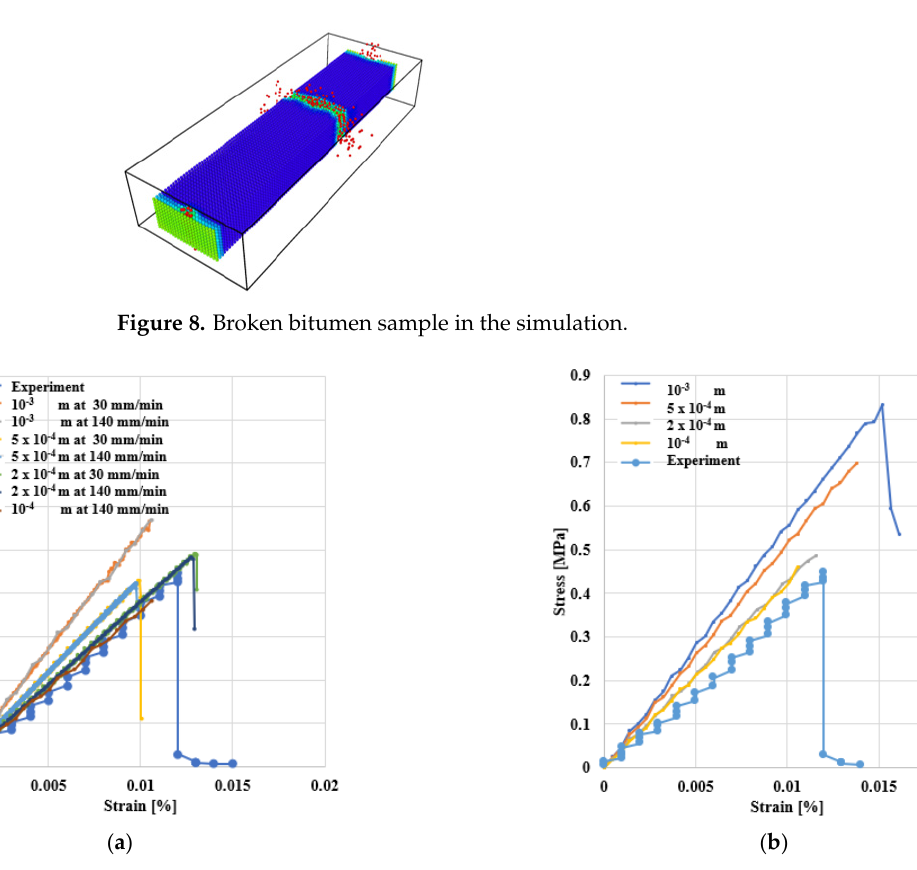
Figure 9. Stress/strain of bitumen beams at different resolutions and loading rate and comparison with other experiments [45]. ( a ) In 3D and ( b ) as a thin plate.